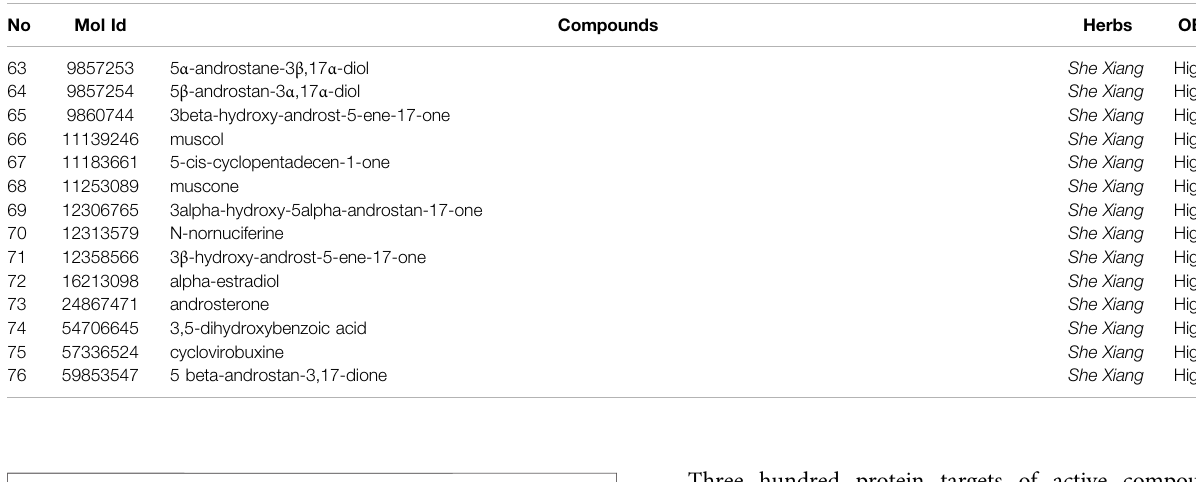
pill were predicted by TCMSP and the SwissTargetPrediction database; then, the protein names were transferred to gene symbols using the UniProt database. In total, 3,968 target genes related to TNBC stem cells were collected from